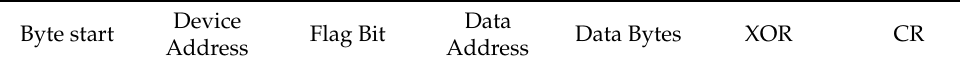
Table 3. Upper computer data write